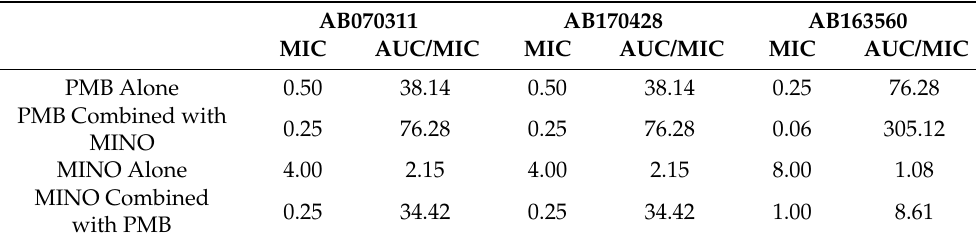
Table 3. PK/PD calculations of tested CRAB